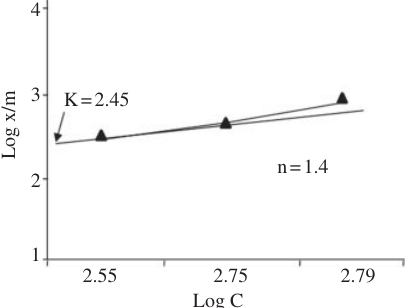
Fig. 4. Color adsorption data at different effluent: biomass ratio. ‘x/m’ is the amount of color adsorbed per unit biomass and C’ is the amount of color remaining in the effluent after decolorization